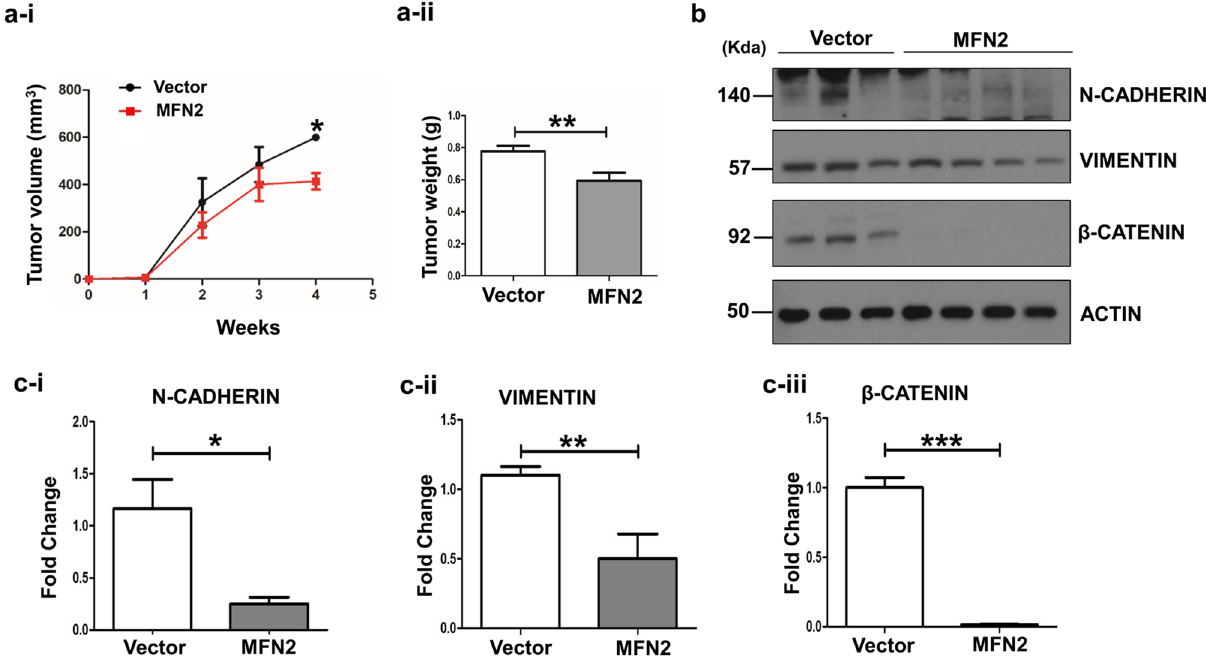
Figure 5. Tumor growth in a mouse xenograft model after gain of function of MFN2 . The gain of function of MFN2 in the Cal62 cell line was investigated in a subcutaneous xenograft model. ( a-i ) Graph of tumor growth to determine whether MFN2 overexpression inhibits tumor growth. ( a-ii ) Graph of tumor volume. ( b ) Immunoblotting of Vimentin, N-cadherin, and β-catenin using in vivo tumor samples. ( c-i ) Quantification of ( b ) Vimentin. ( c-ii ) Quantification of ( b ) N-cadherin. ( c-iii ) Quantification of ( b ) β-catenin. Asterisks (p < 0.05 [*], p < 0.01 [**], p < 0.001 [***]) indicate significant differences from the statistical analyses. Each data point represents the mean ± standard error of three independent